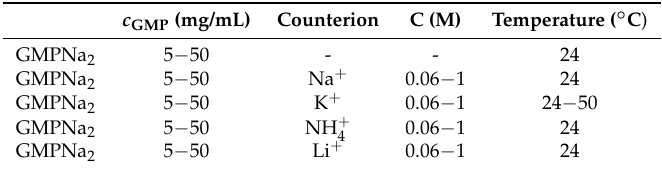
Table 1. Complete list of investigated samples.